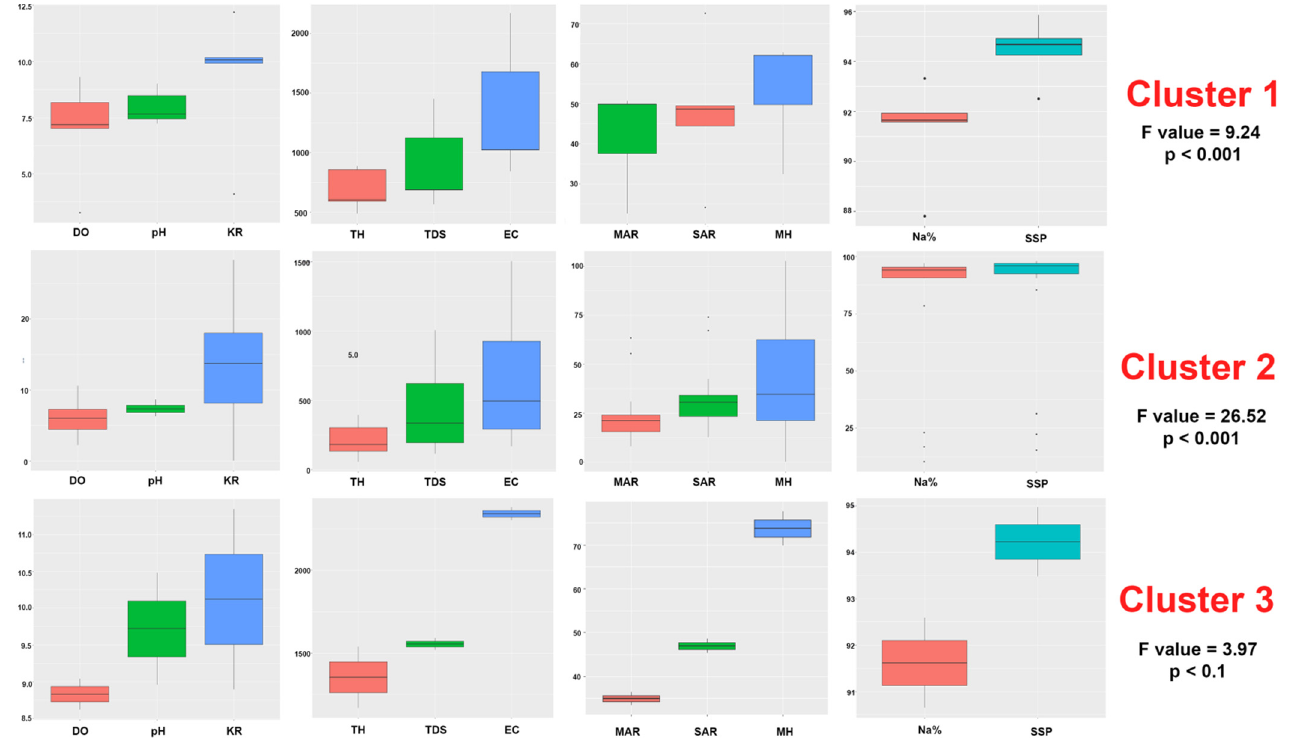
Figure 4. Boxplots displaying the variation of irrigation water indices analyzed following three cluster sites in the Asir region. Results of two-way ANOVAs are given between brackets as F-statistics (with degrees of freedom of numerator and denominator, respectively), and significance . The same letters associated with average values (white circles) are significantly not different following Tukey’s post-hoc test. Table 3. Classes of quality indices applied for irrigation water in the study